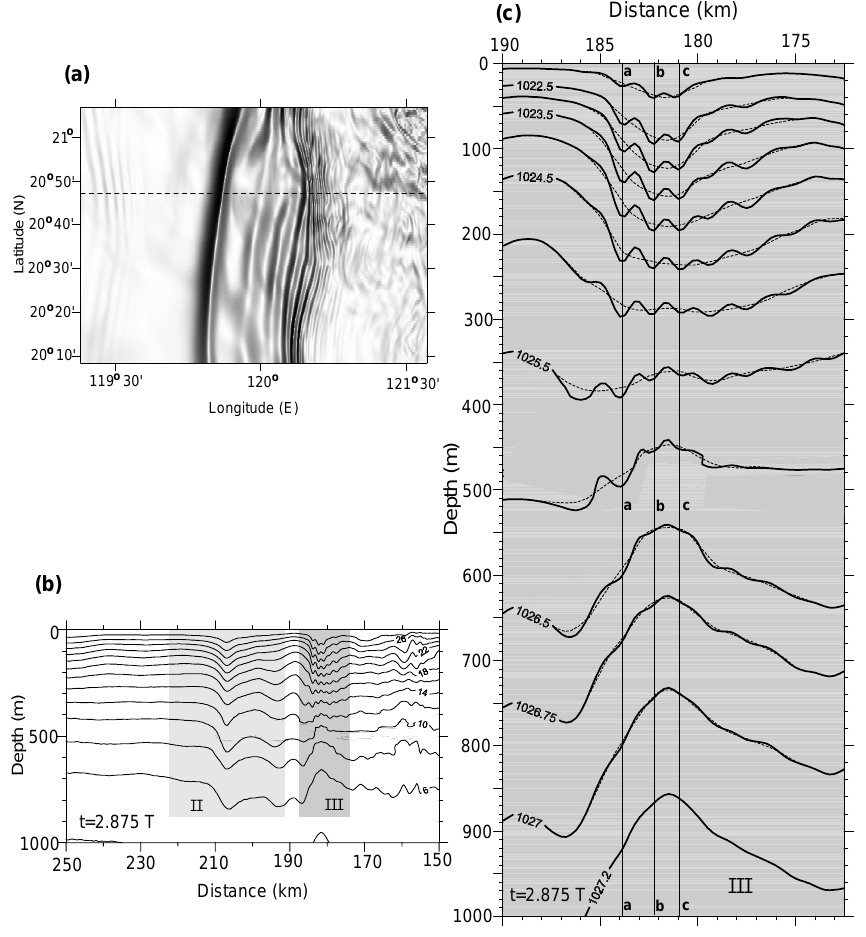
Fig. 8. (a) Surface signature of first-mode solitary waves and packet of short waves at t = 2 . 875 T . (b) Model-predicted temperature field along the cross-section shown in panel (a) by a dashed line. (c) Zoom of the element III as a density field. Dashed lines represent averaged isopicnals of a 2-nd mode solitary wave after removal of short-scale oscillations.